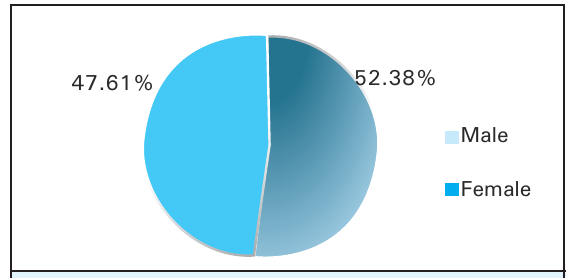
Figure 2. Showing sex distribution of retinoblastoma (n=42).